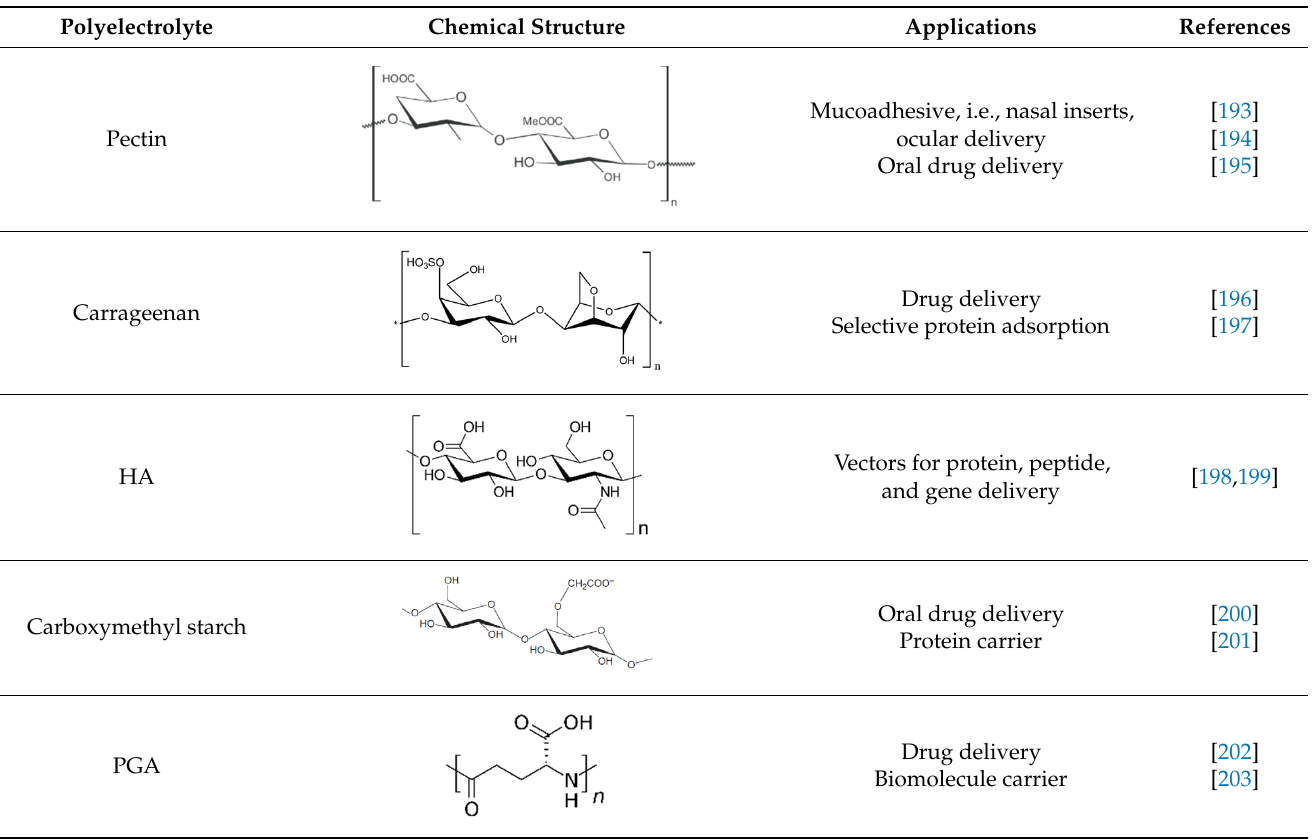
weak bonding interactions (i) that facilitate the reversible conformation of the